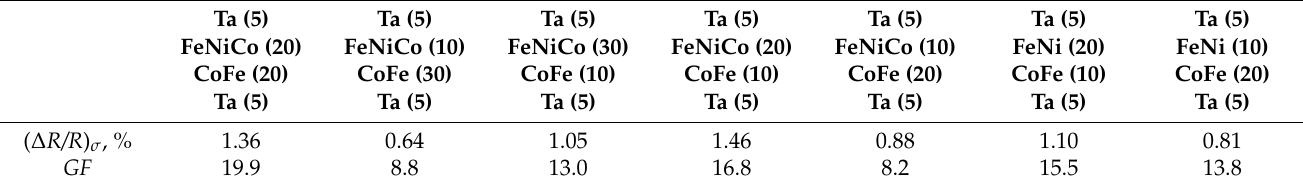
Table 2. Magnetoresistive characteristics of nanostructures (layer thickness in nm).